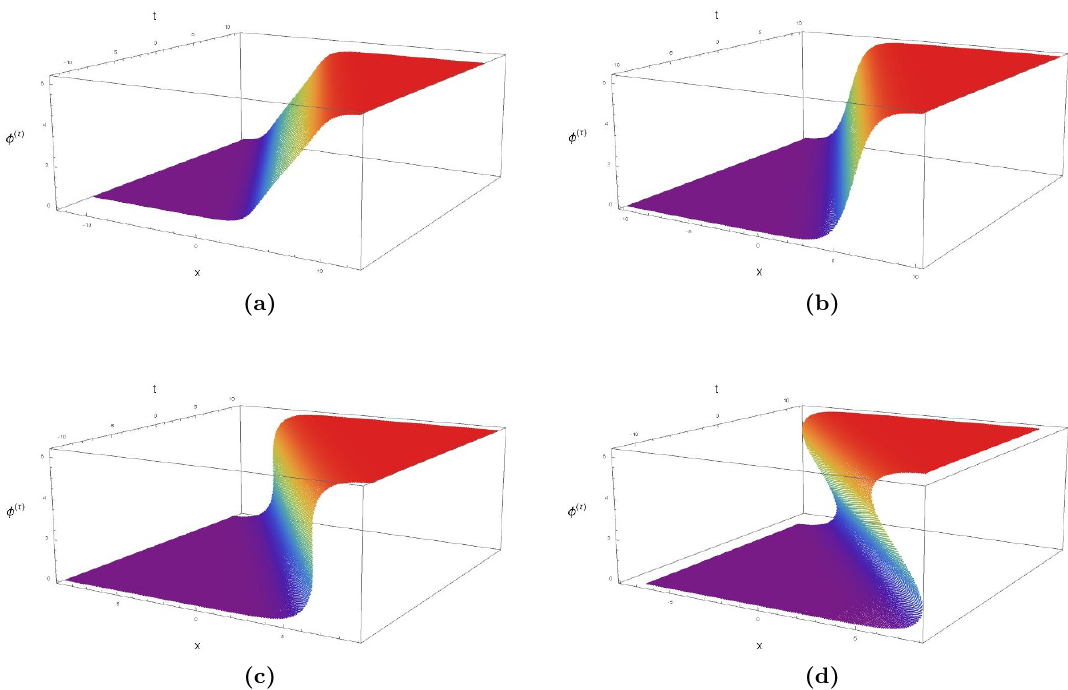
Figure 2. The T (cid:22) T -deformed moving one-kink solution ( m = (cid:12) = 1 ; a = 2), for di(cid:11)erent values of the perturbation parameter (cid:28) . Figure 2b represents the undeformed solution. Figure 2a corresponds to (cid:28) = (cid:0) 1 = 4, while (cid:12)gures 2c and 2d correspond to (cid:28) = 1 = 8 and (cid:28) = 1 = 3, respectively. Notice that at (cid:28) = 1 = 8 a shock-wave singularity